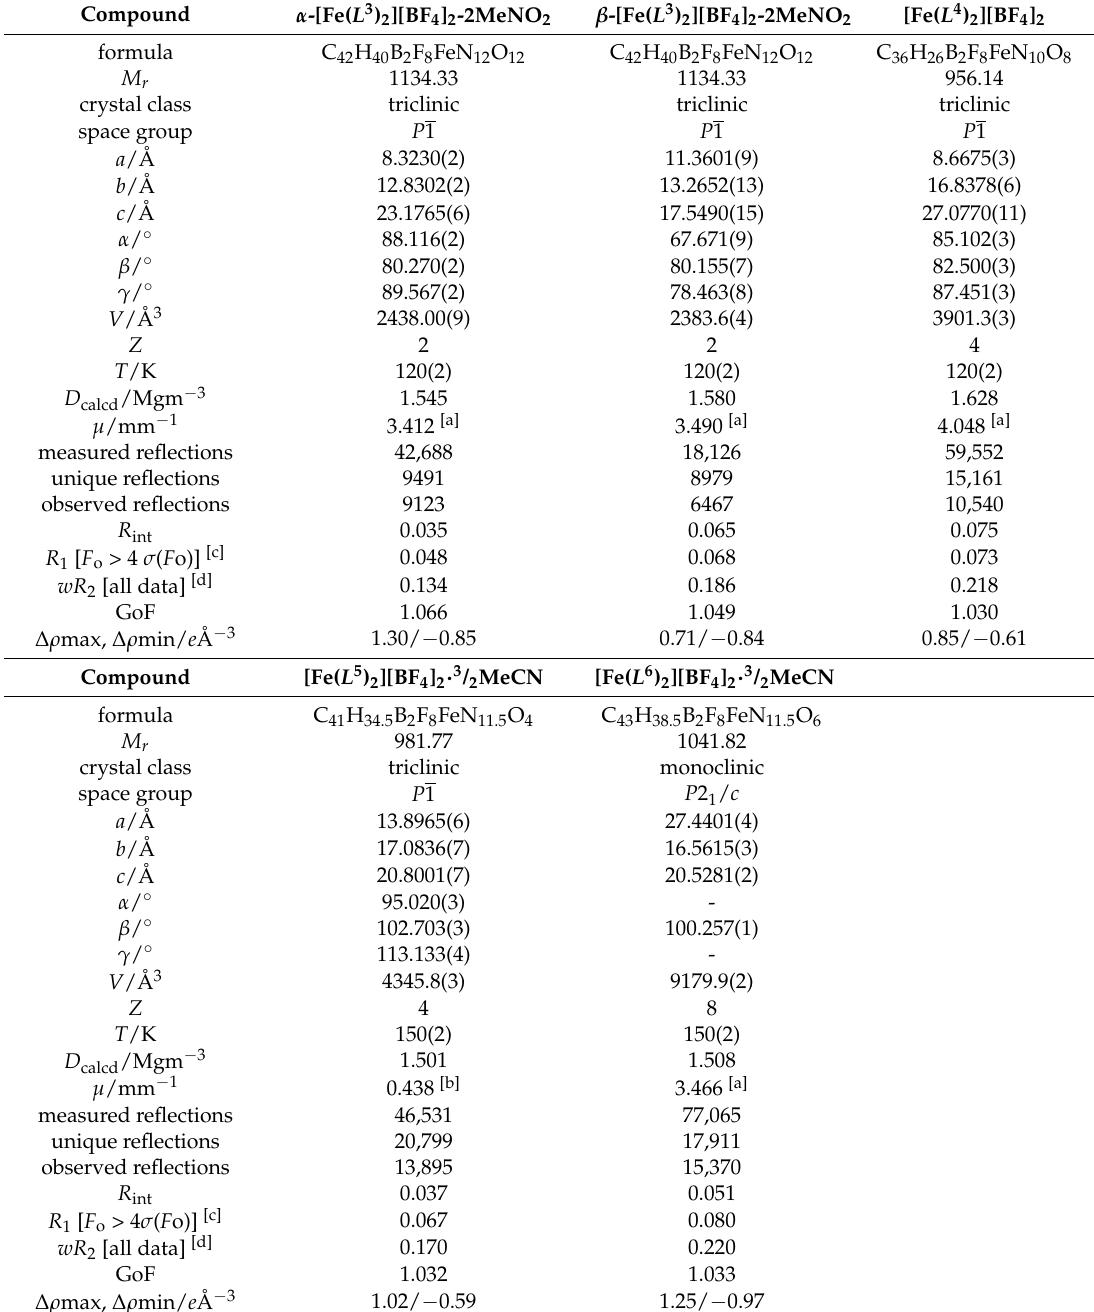
Table 4. Experimental details for the metal complex crystal structures in this